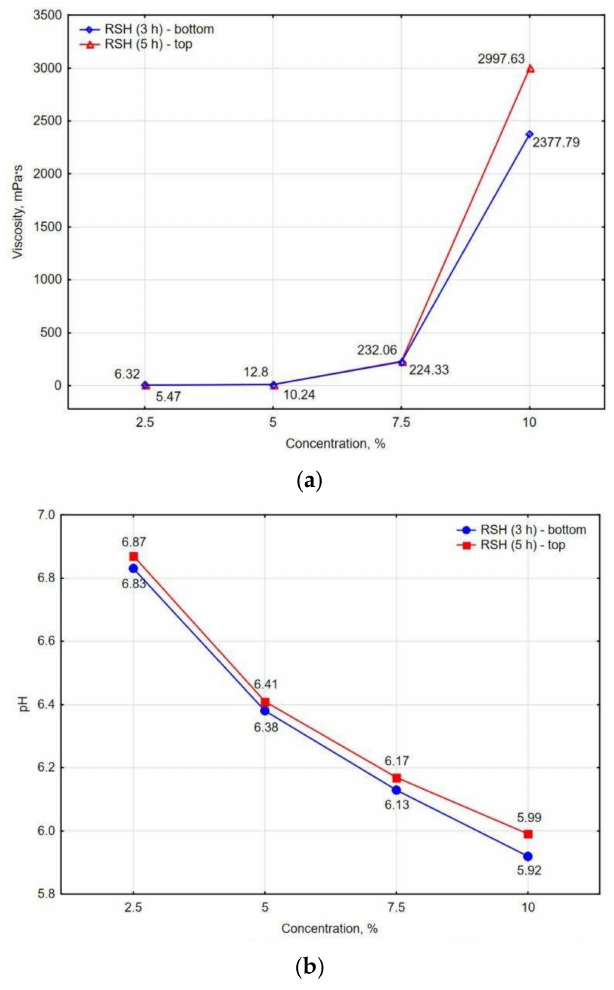
Figure 2. Characteristics of the retrograded starch hydrogel: ( a ) viscosity and ( b )